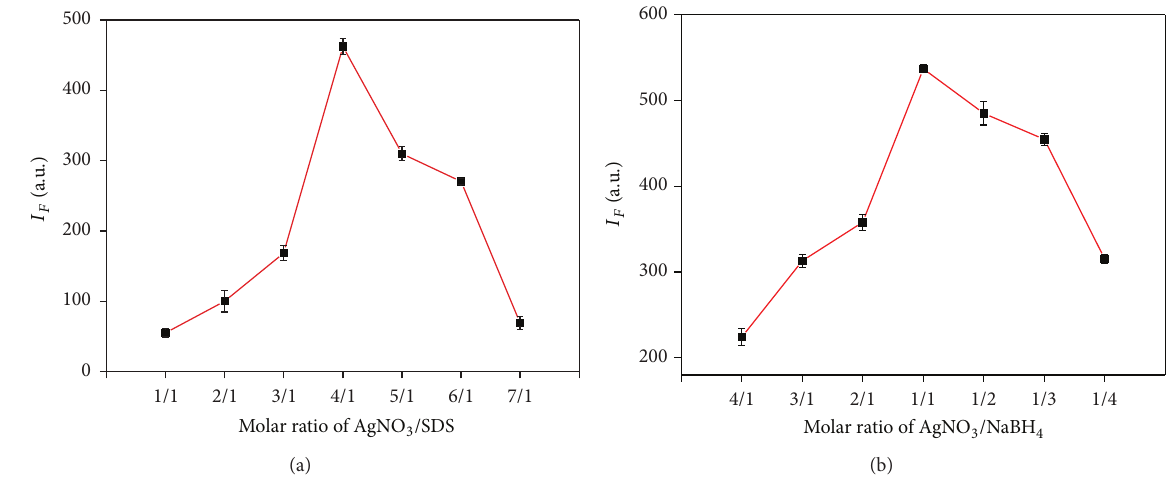
Figure 3: The effect of molar ratio of (a) AgNO 3 /SDS and (b) AgNO 3 /NaBH 4 on the fluorescence intensity of Ag NCs.